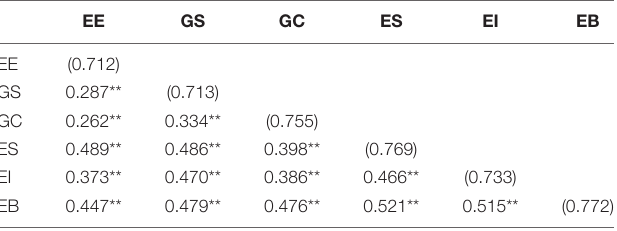
TABLE 1 | Results of tests of reliability and validity. TABLE 2 | Correlations among the